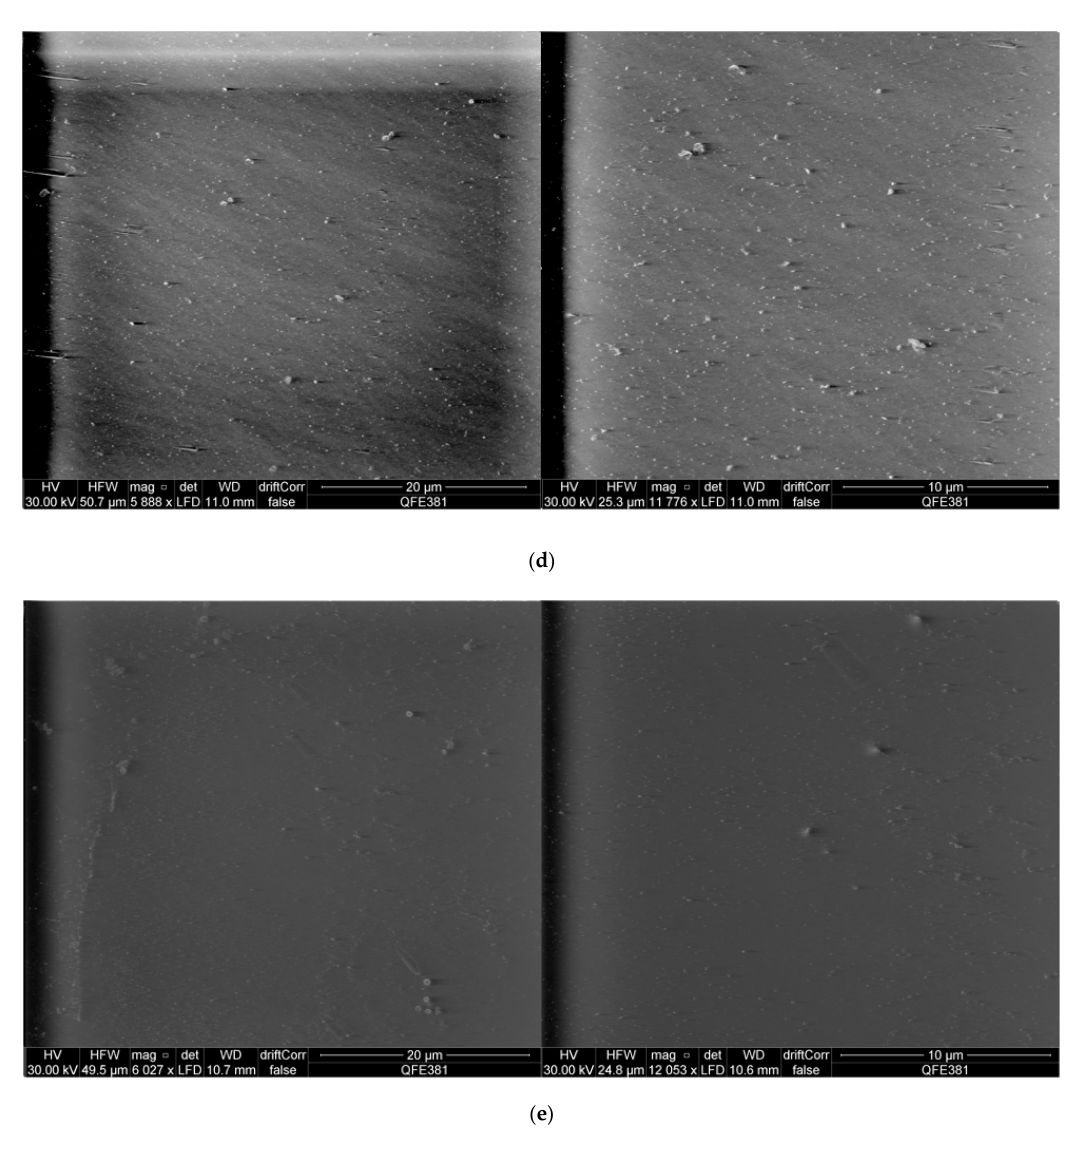
Figure 9. Scanning electron microscopy images of S.aureus biofilms treated with purified synthetic phylloseptin-PTa and phylloseptin-PHa. ( a ) Images of S. aureus biofilms only; ( b ) Images of S. aureus biofilms treated with phylloseptin-PTa at MBEC; ( c ) Images of S. aureus biofilms treated with phylloseptin-PTa at 2 × MBEC; ( d ) Images of S. aureus biofilms treated with phylloseptin-PHa at MBEC; ( e ) Images of S. aureus biofilms treated with phylloseptin-PHa at 2 × MBEC. Scale bars were set at 20 μ m and 10 μ m.